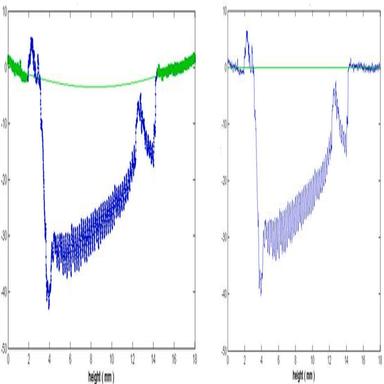
Removal of manufacturing form from head taper surface. Averaged 2D profile with selected unworn data in green (left) and real-time fitting result (right) . (For interpretation of the references to colour in this figure legend, the reader is referred to the Web version of this article.)